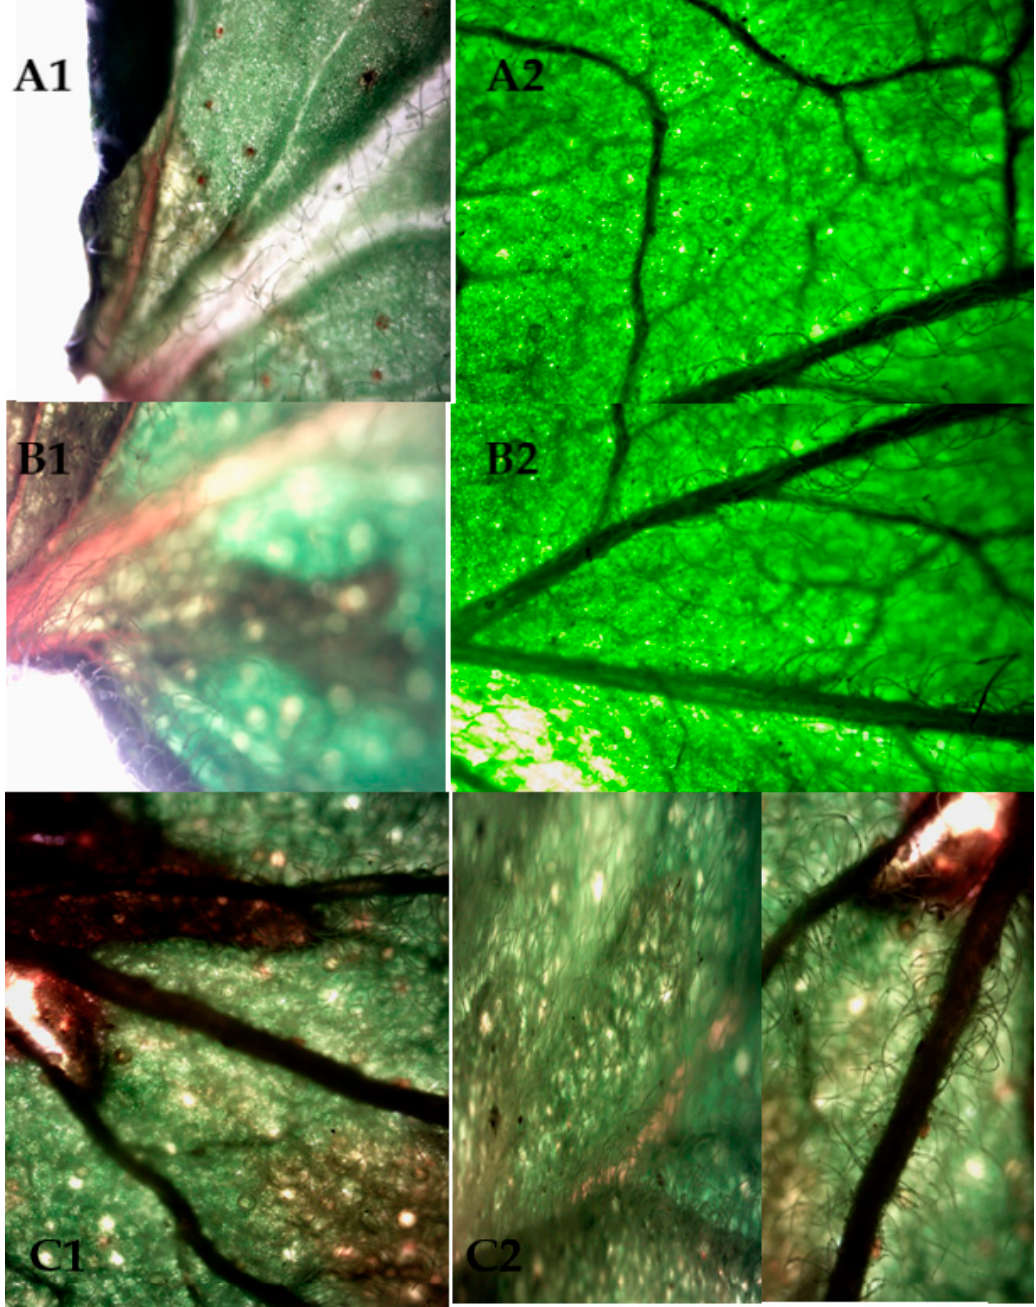
Figure 4. Microscopic pictures of za’atar leaves, ( A1 ) fresh image near leave stem, ( A2 ) fresh image near leave center, ( B1 ) freeze-dried leave near stem, ( B2 ) freeze-dried leave center, ( C1 ) solar dried leave near stem, ( C2 ) solar dried near center.